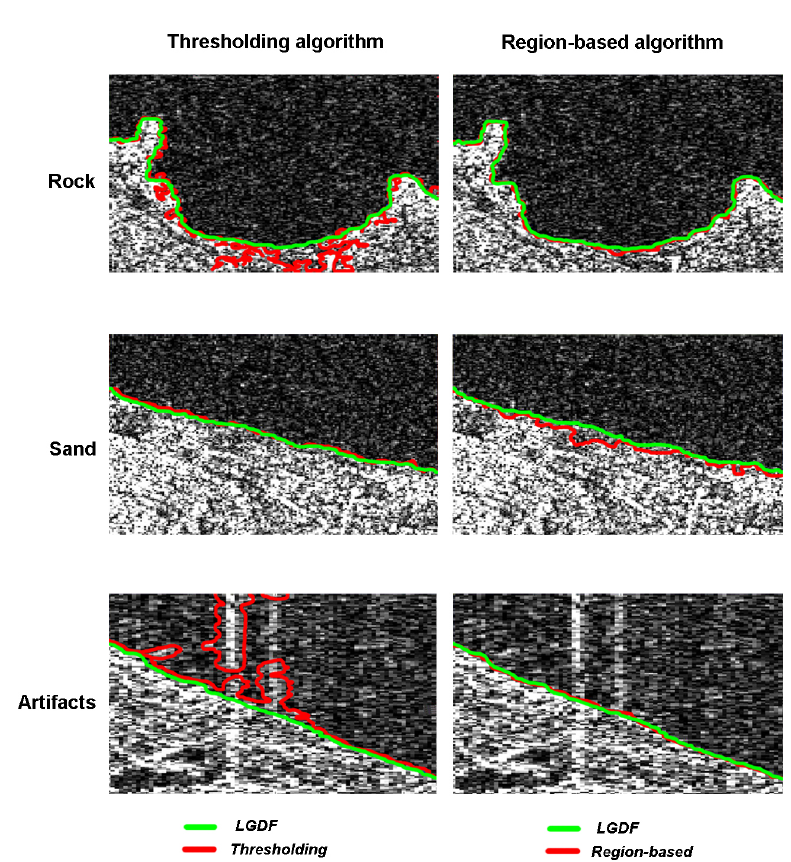
Figure 5. Segmentation results using thresholding, region-based algorithm and LGDF in the three examined sub-sites (rock coast, sandy coast and